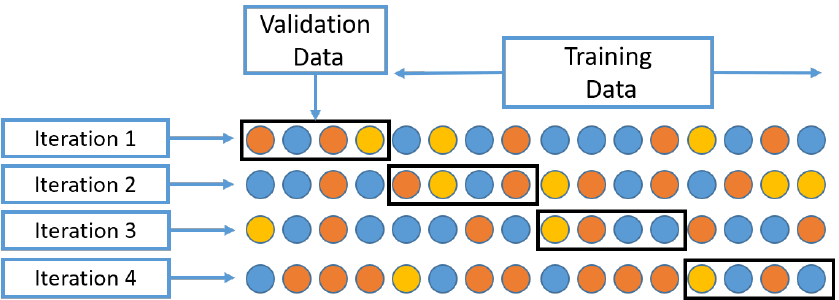
Figure 1. Graphical depiction of k-fold cross validation with 4